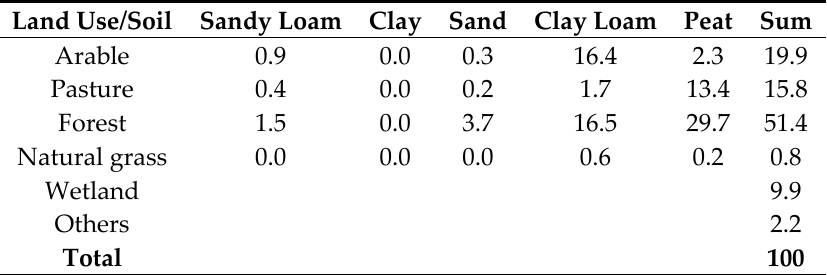
Figure 1. Map of River Leivajõgi watershed. Table 1. Soil areas (%) of different land use types for the Leivajõgi